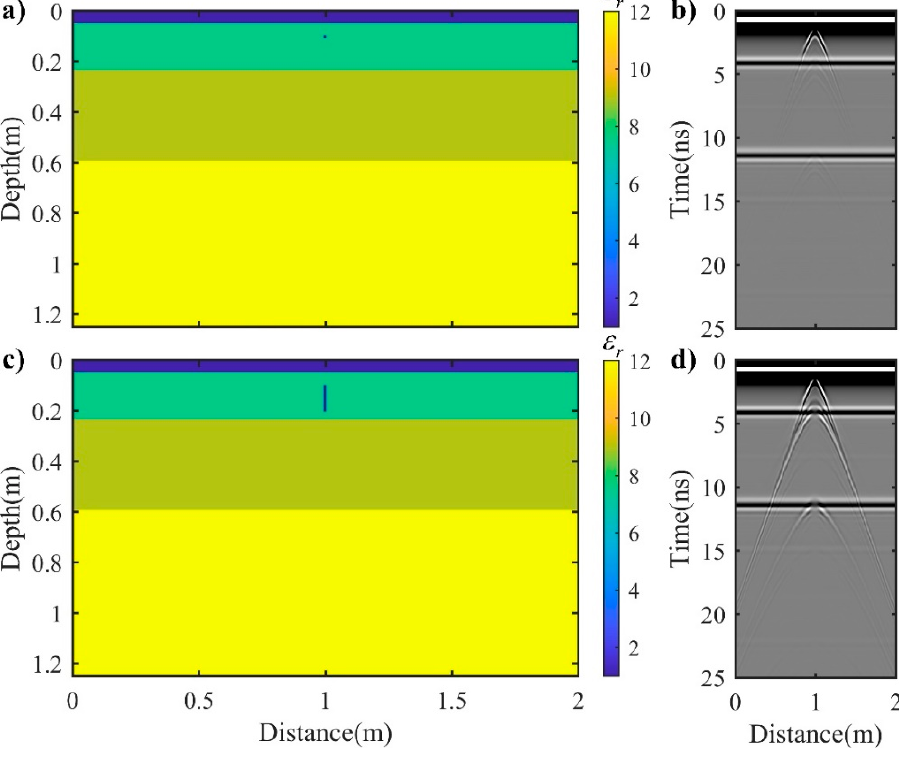
Figure 3. ( a ) Model 3 and ( c ) Model 4, ( b ) and ( d ) simulated GPR profiles for Models 3 and 4, re-